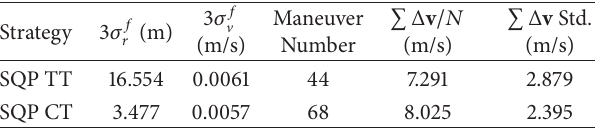
Table 1: Monte Carlo shooting results under TLE level accuracy initial relative state